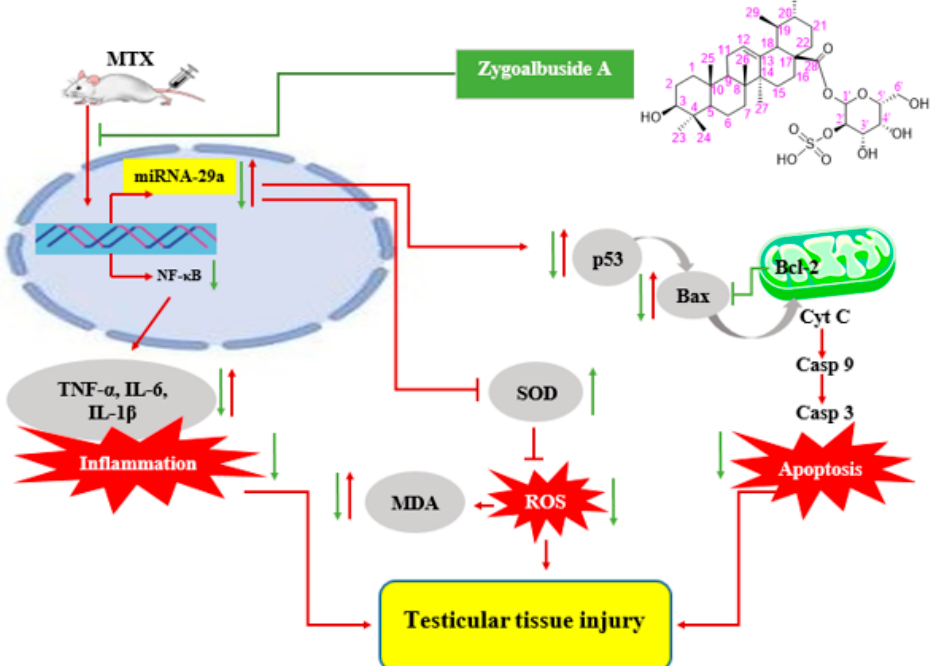
Figure 7. Protective mechanism of zygo-albuside A against methotrexate-induced testicular damage. Red arrows indicate the effects of MTX injection. Green arrows indicate the effects of zygo-albuside A administration. MTX; methotrexate, NF- κ B; nuclear factor kappa B, TNF- α ; tumor necrosis factor- α , IL-1 β ; interleukin 1 β , IL-6; interleukin-6, SOD; superoxide dismutase, ROS; reactive oxygen species, MDA; malondialdehyde, Cyt C; cytochrome C, Casp; caspase.